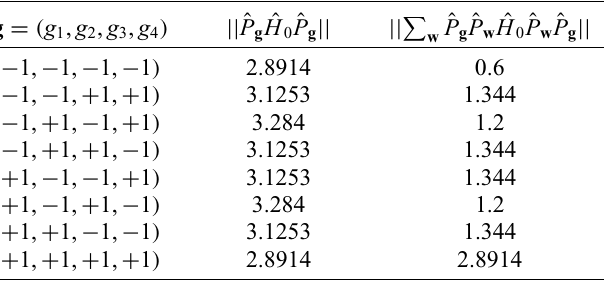
TABLE III. The 2-norm of the projections of ˆ H 0 and (cid:2) ˆ P ˆ P ˆ H 0 w w onto the superselection sectors g constituting the w (cid:3) (see Table I). The nonzero renor- superposition initial state | ψ z 0 malized norms show that LPG protection does not trivially freeze dynamics, but that rather in its presence there is renormalized dynamics in the relevant sectors g . g = ( g 1 , g 2 , g 3 , g 4